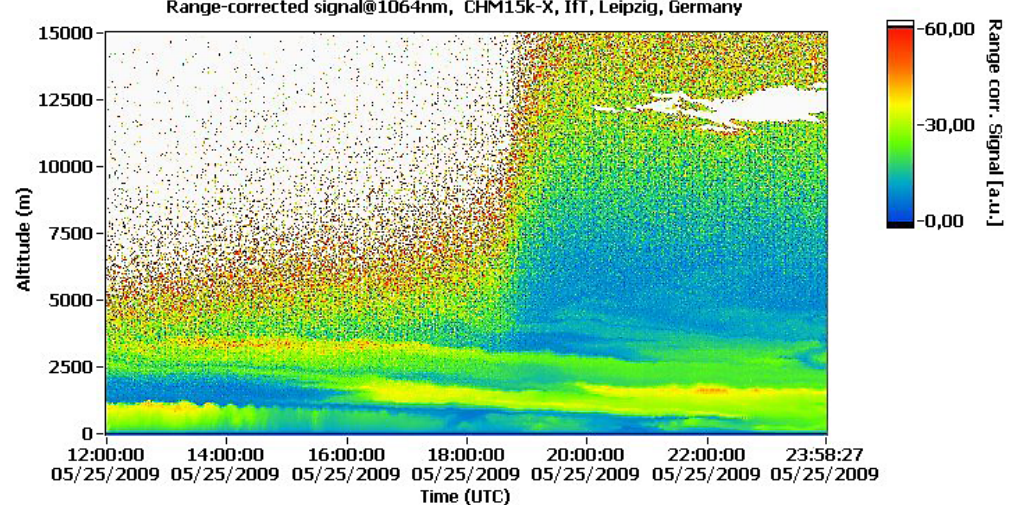
Fig. 1. Temporal development of the range corrected signal of the ceilometer Jenoptik CHM15k-X on 25 May 2009 from 12:00–23:59UTC. The data have a temporal resolution of 30s and a vertical resolution of 15m. Above the boundary layer (top height ≤ 1200m) a lofted Saharan dust layer is